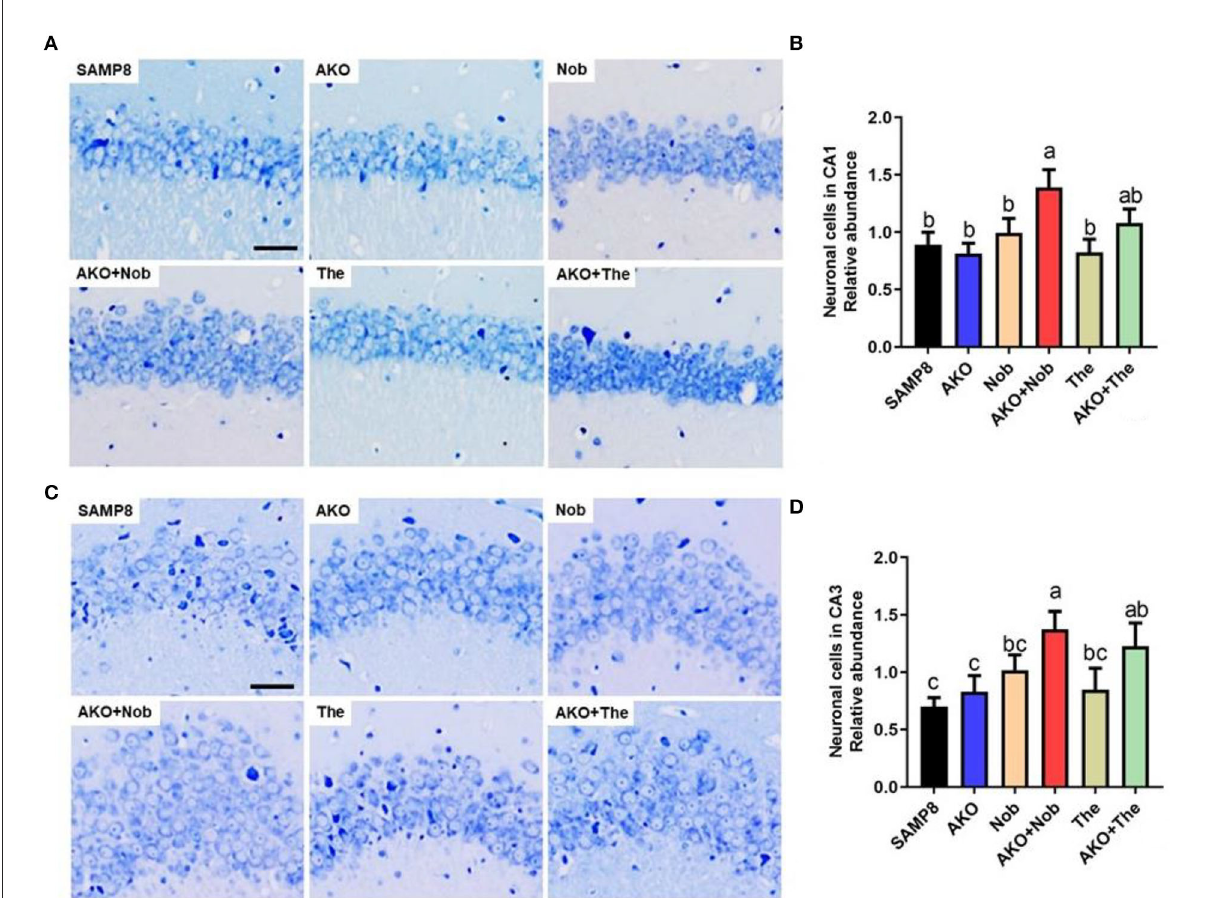
FIGURE3 Effects of neuronal cell loss. (A) The representative image in CA1 of the hippocampus stained by Nissl staining, scale bar = 200 µ m. (B) The relative number of neuronal cells in CA1 of the hippocampus. (C) The representative image in the CA3 of hippocampus stained by Nissl staining. (D) The relative number of neuronal cells in CA3 of the hippocampus. All data were presented as mean ± SEM. Different letters indicate a significant difference at p < 0.05 by ANOVA.